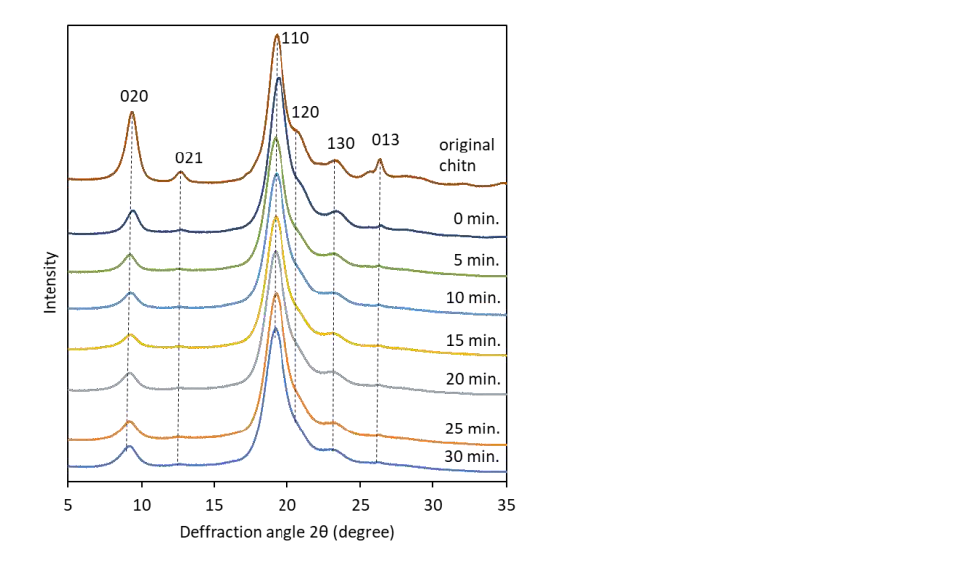
Figure 6. X- ray diffraction patterns of pure α - chitin powder and partially deacetylated α -chitin with different ultrasonication time.